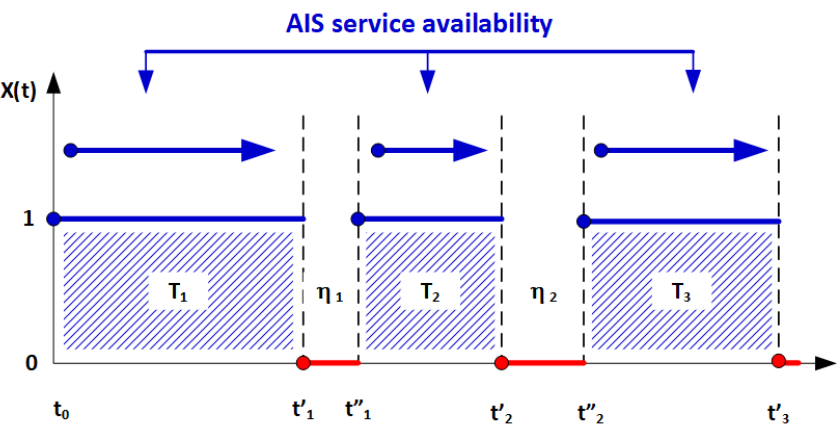
Figure 1. A graphic presentation of the AIS service for a single navigation parameter and for m = 1 streams of data indexed with the MMSI.